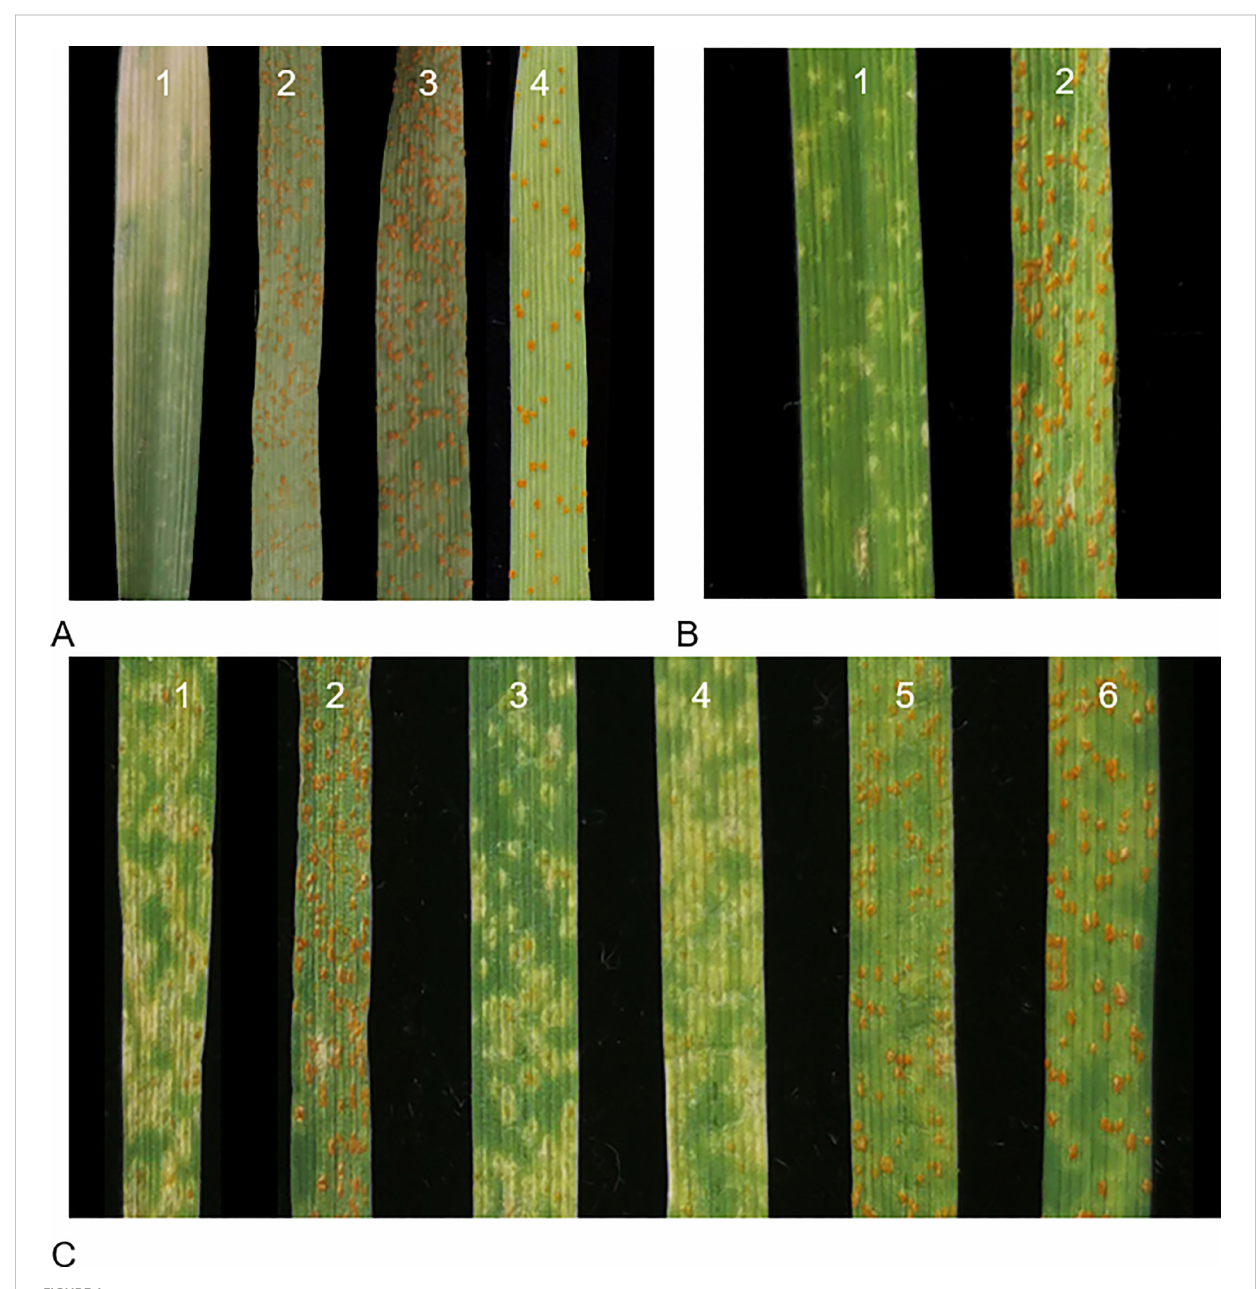
FIGURE 1 Seedling responses 15 days post-inoculation with the Pt race PHT. (A) Ofanto (1), IT 0;, (2) Shi4185 IT 4, (3) ND4503 IT 4, and (4) Mo75 IT 4; (B) F 2 plants from cross Ofanto × Mo75, (1) IT 1, (2) IT 4; (C) F 1 plants of (1) Ofanto/Shi4185 IT 1; (2) Ofanto/ND4503 IT 4; (3 – 4) resistant plants IT 1 and (5 – 6) susceptible plants IT 4 from the three-way